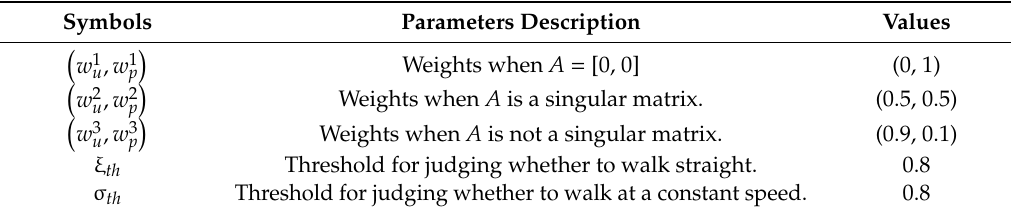
Table 1. Preset parameters for the hybrid localization system.